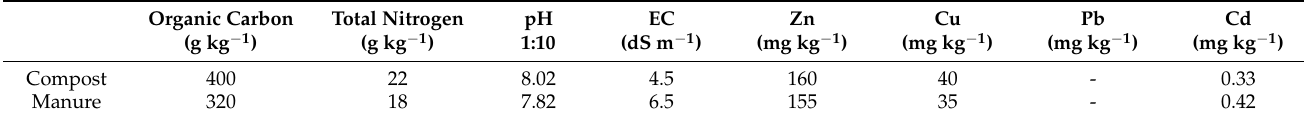
Table 2. Chemical analysis of compost and